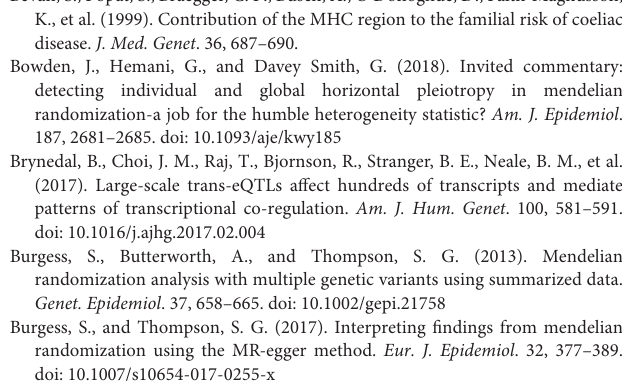
Supplementary Table 9 | Mediation results when correcting TRAFD1 expression for the nearby SH2B3 expression. Columns are: the ENSEMBL id ( ensemble_id ); the hgnc gene name ( gene_name ); and the mediation Z score difference ( Z_score_difference ), p -value ( p_value ) and Pearson correlation ( correlation ) between the trans -eQTL top variant and the residual of TRAFD1 expression, after correction for SH2B3 expression. Supplementary Table 10 | Significant REACTOME 2016 enrichment of TRAFD1- mediated genes. Results from the enrichr API using the mediated TRAFD1 trans genes as query. Columns indicate: the enrichment background ( background ); the enrichment term in the background ( term_name ); the non-corrected p- value of enrichment for this term ( p_value) and Z score ( Z_score ); enrichr combined score ( combined_score ); cis -prioritized genes found in each the term ( overlapping_genes ) and the multiple-testing-corrected p -value ( adjusted_p_value ). Supplementary Table 11 | Differential expression results of the THP-1 experiments. This table shows differential expression analysis of the THP-1 cells with 3h LPS treatment (LPS) or without LPS (Unstim) in wild type (WT), scrambled control siRNA (SCR) or TRAFD1 knock down conditions (KD). All conditions and treatments were performed in triplicate. Complete DESEQ2 results are shown for each possible comparison in each tab. For each gene the columns show: the ensembl id per gene ( ensembl_id ); the mean corrected expression of the gene ( baseMean ); the log2 fold change of the comparison ( log2FoldChange ); the standard error of this log2 fold change ( lfcSE ); a t-statistic of the log2foldchange ( stat ); the p -value ( pvalue ); and the multiple testing adjusted p -value ( padj ). The direction of the effect is always toward the second term in the tab name: if a log2 fold change is positive and the tab name is, for example, “WT_LPS_vs_SCR_LPS,” then the expression of the gene is increased in the SCR_LPS samples compared to the WT_LPS samples. Supplementary Table 12 | Results of DE analyses from all cell-type- and context-specific data available for this study (datasets). This table lists all results for the DE analyses (Significant DE genes are defined as padj < 0.05 and log2 fold change > |1|) and a summary report of the overlap with TRAFD1 trans -mediated genes ( overlap with trans genes + TRAFD1 ) and relative enrichment. The DE gene lists (padj < 0.05 and log2 fold change > |1|) for each dataset are given in individual sheets. In the sheet “enrichment,” columns upregulated and downregulated indicate if the trans -mediated genes are up- or downregulated under stimulated conditions compared to control conditions in each dataset. Enrichment of all the trans -mediated genes in the DE genes was determined using a Fisher’s exact test and the enrichment p -value is shown in the column enrichment